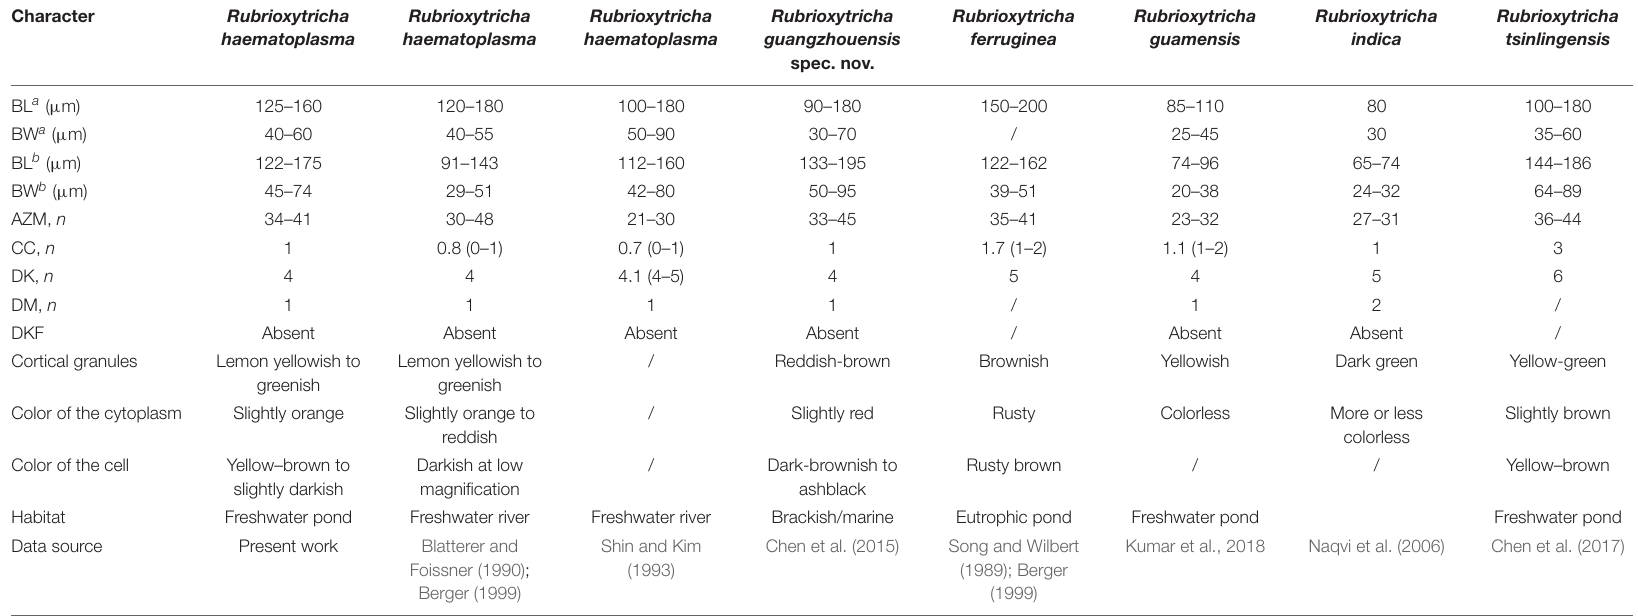
TABLE 3 | Morphological and morphometric comparison of Rubrioxytricha